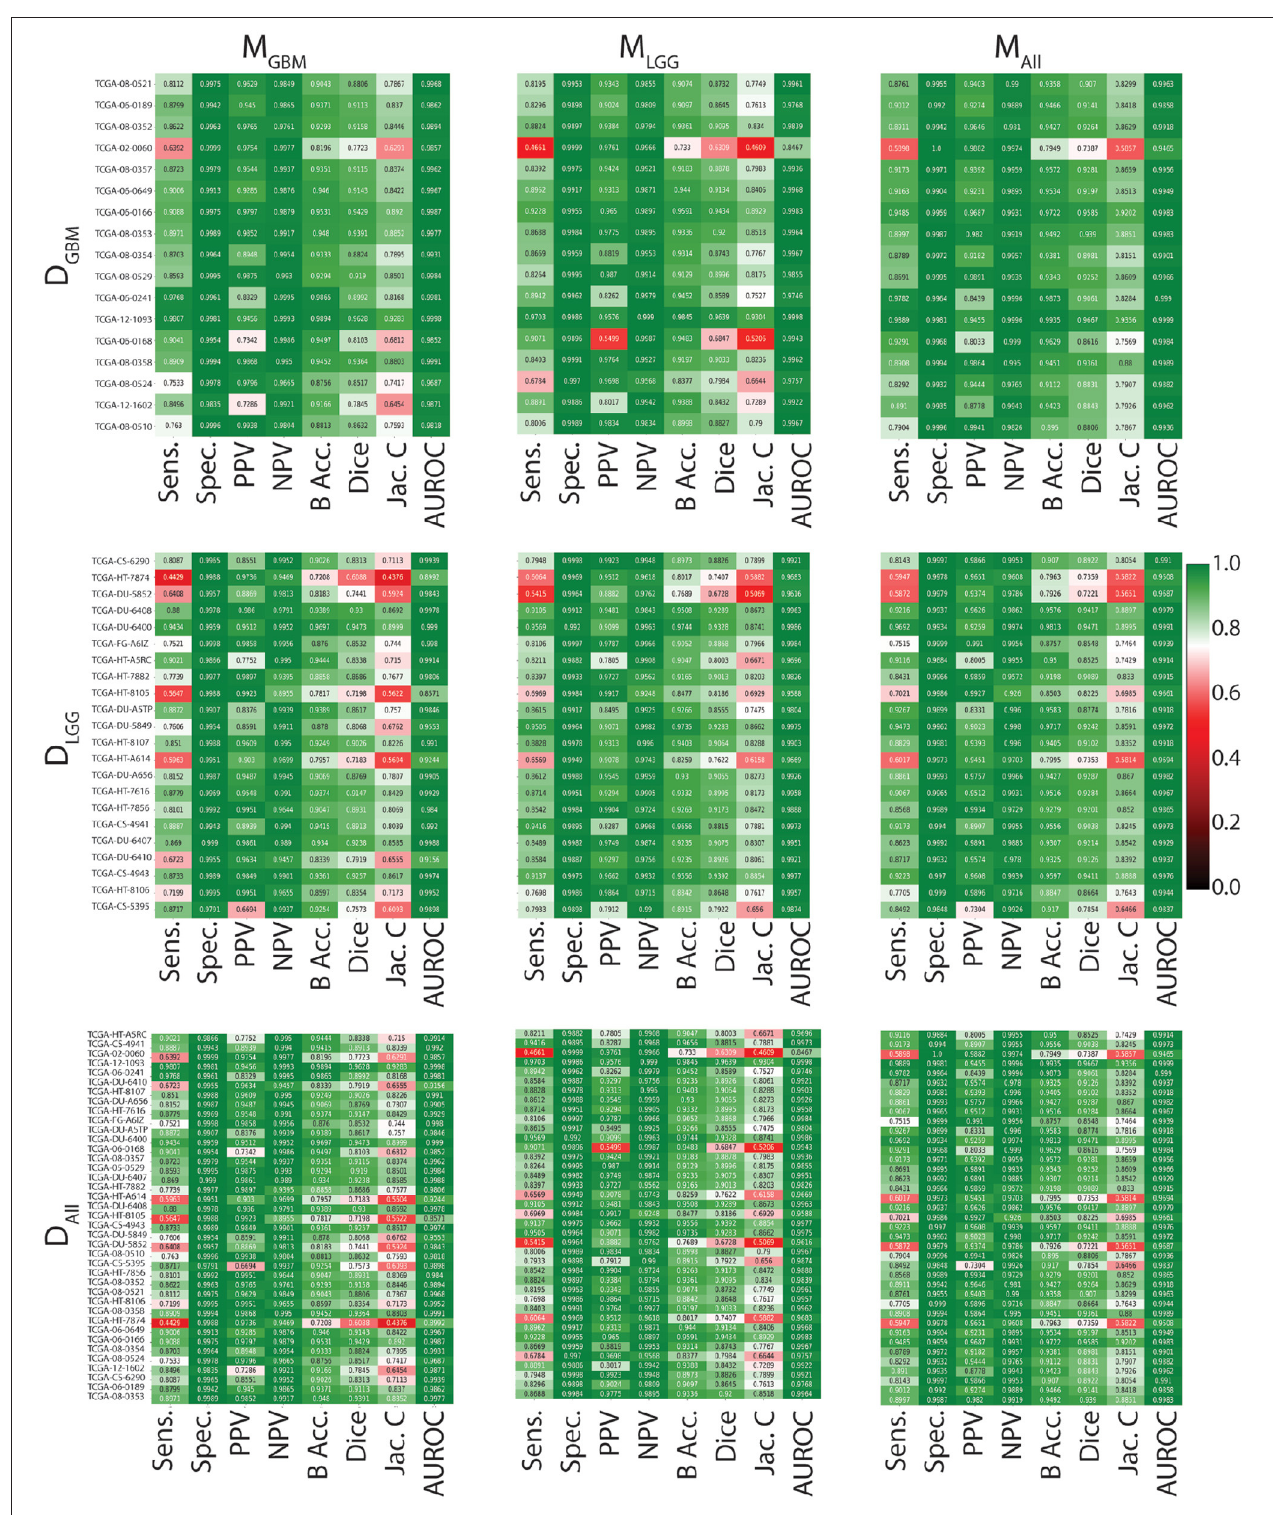
FIGURE 3 | Heat maps indicating patient-level performance metrics. Rows represent test datasets ( D GBM , D LGG , D ALL ) and columns represent ML algorithms ( M GBM , M LGG , M ALL ). D ALL is formed by concatenating the first two rows. In each individual heat map, rows represent model performance on a particular test dataset and columns represent segmentation metrics. Patients for whom all models perform similarly worse are indicated in red.